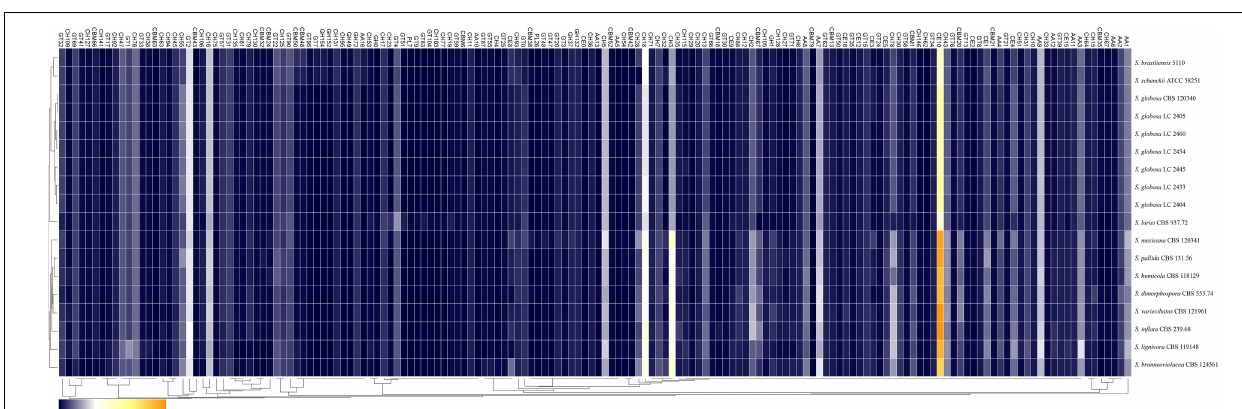
FIGURE 4 | Comparison of the CAZymes identified in the genomes of the genus Sporothrix. CAZy-coding genes falling into 141 families and CBM-coding genes in 19 families were identified in the genomes of the genus Sporothrix . There was a higher abundance of PPD enzyme genes, especially GH1, GH2, GH3, GH28, GH43, GH78, and CE1 in two clinical species ( S. mexicana and S. pallida ) and environmental species. A remarkable gene contraction was observed in the four main clinical species ( S. brasiliensis , S. schenckii , S. globosa, and S. luriei ) including AA3, AA7, CBM20, and CE10 families. Genes of CBM48 and CBM50 expanded